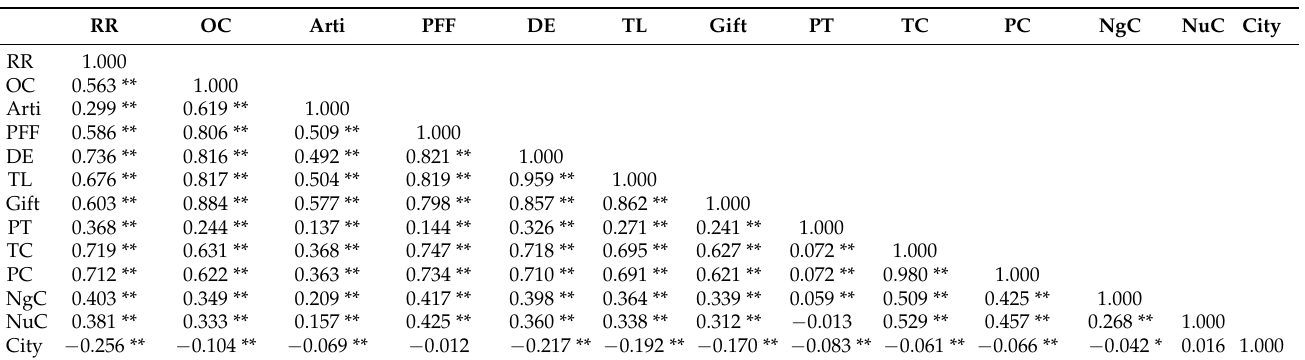
Table 2. Correlation